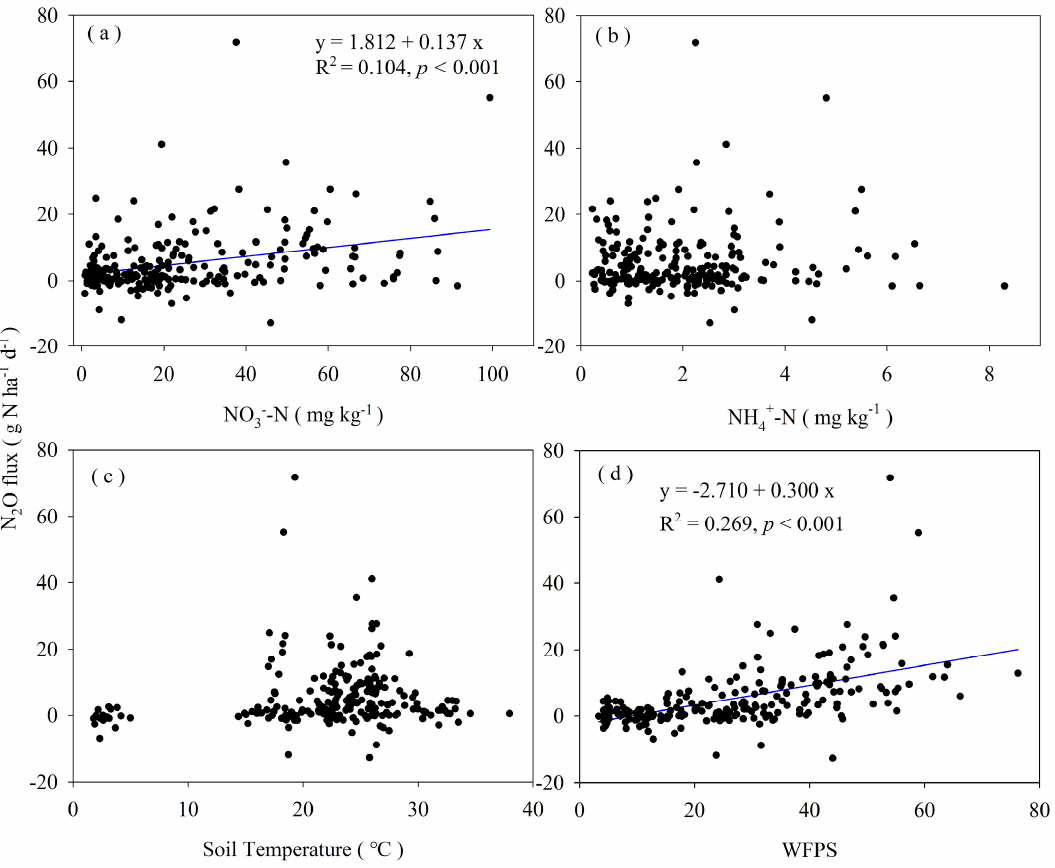
Figure 4. Relationship of the daily N 2 O flux rate with the soil concentrations of NO 3 − − N ( a ) and